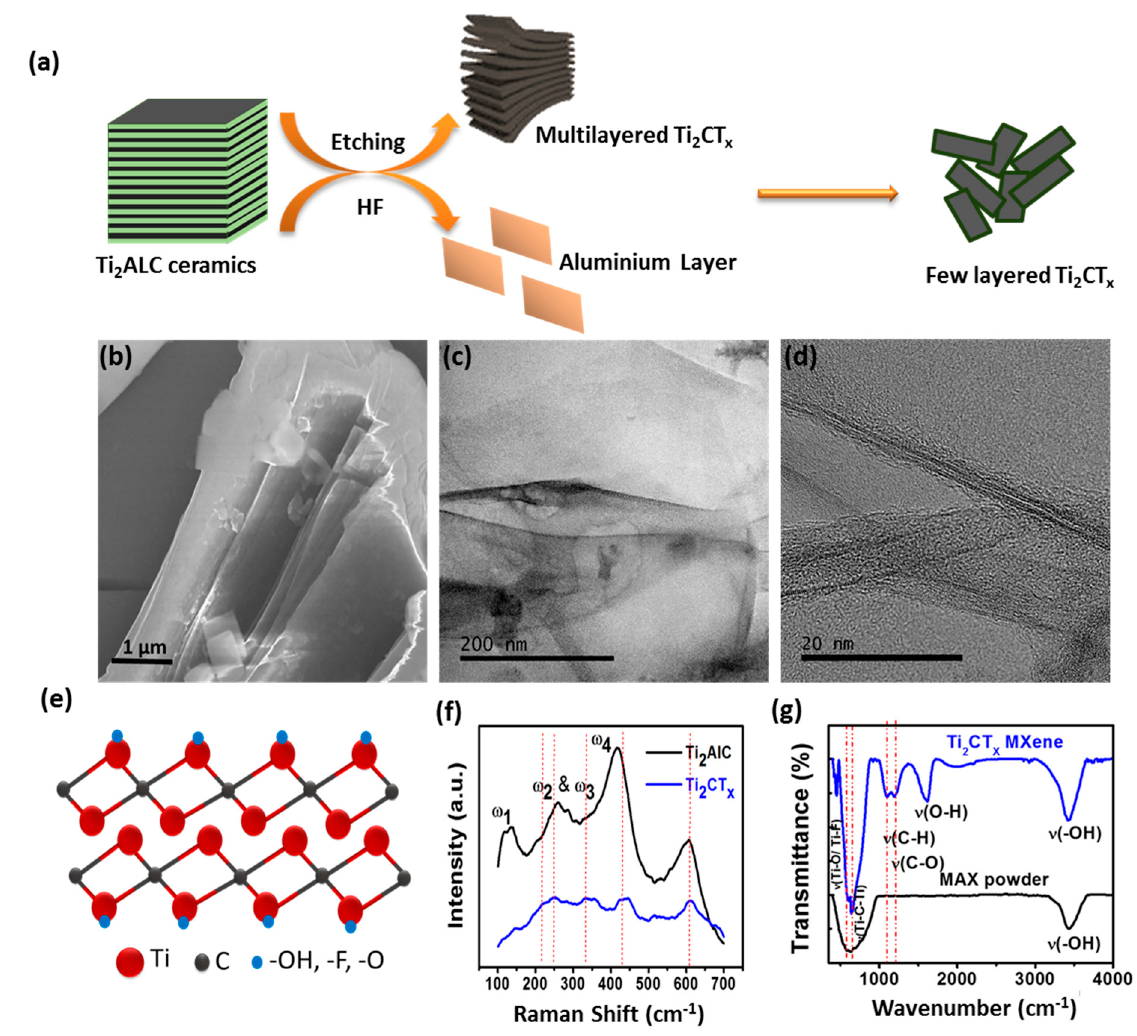
Figure 2. Characterization of etched Ti 2 CTx nanosheets. ( a ) Schematic showing etching of nanosheet; ( b ) SEM micrograph showing a few layered nanosheets; ( c , d ) TEM and HRTEM micrographs confirming the layer composition of nanosheet; ( e ) Model showing atomic structure of Ti 2 CTx; ( f ) Raman spectra confirming a successful production of nanosheet from bulk; ( g ) FTIR spectra showing the presence of various functional groups over etched Ti 2 CTx.